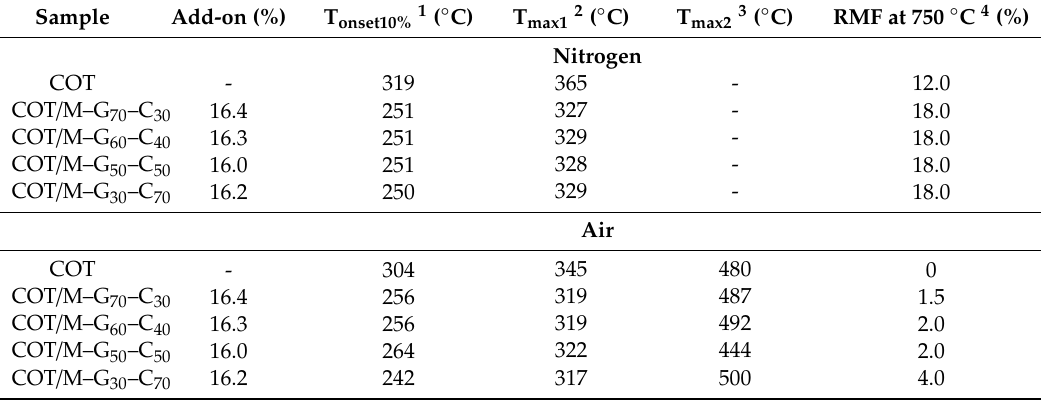
Table 4. Thermal data of PAA-treated cotton fabrics in nitrogen and air by thermogravimetric analysis. Sample